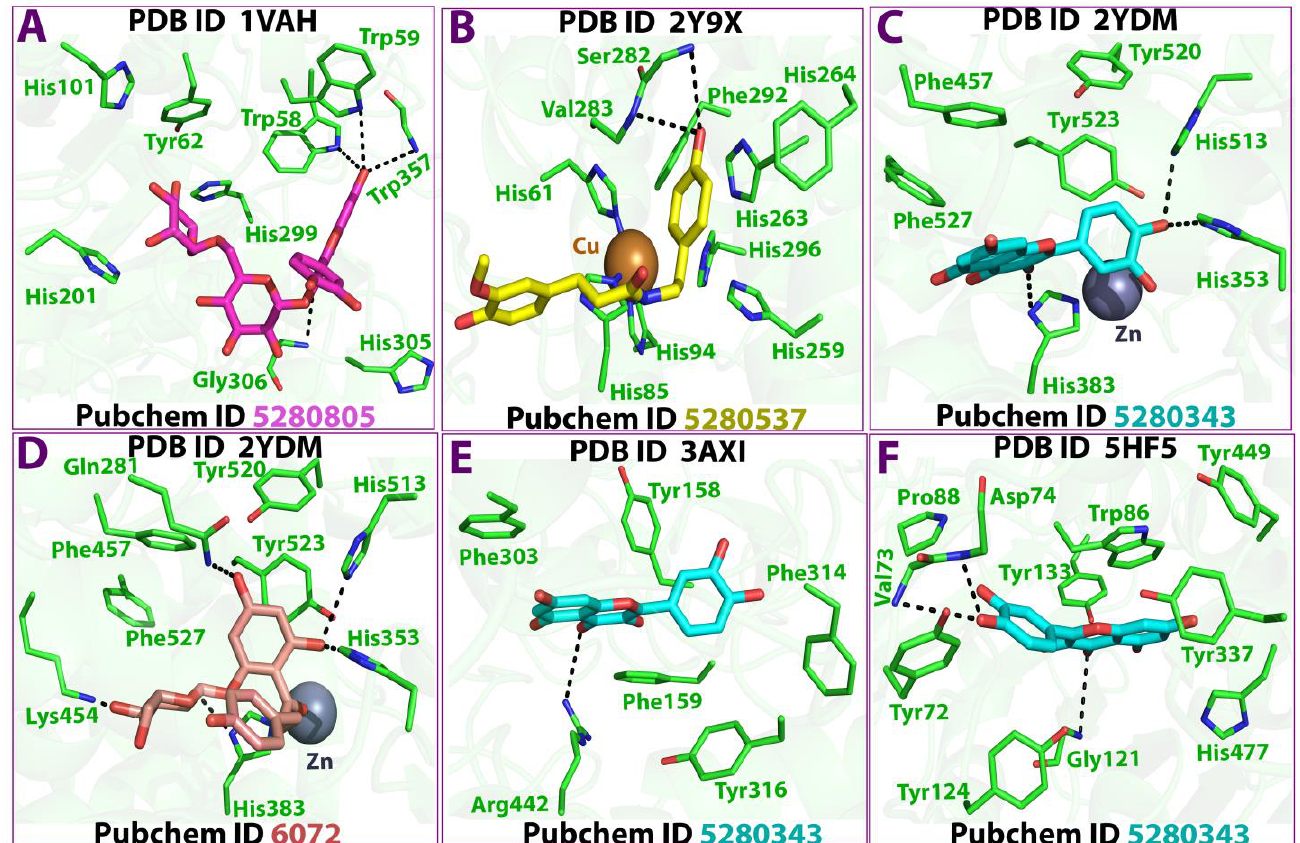
Figure 6. Bond formation during docking ( A – F ) .